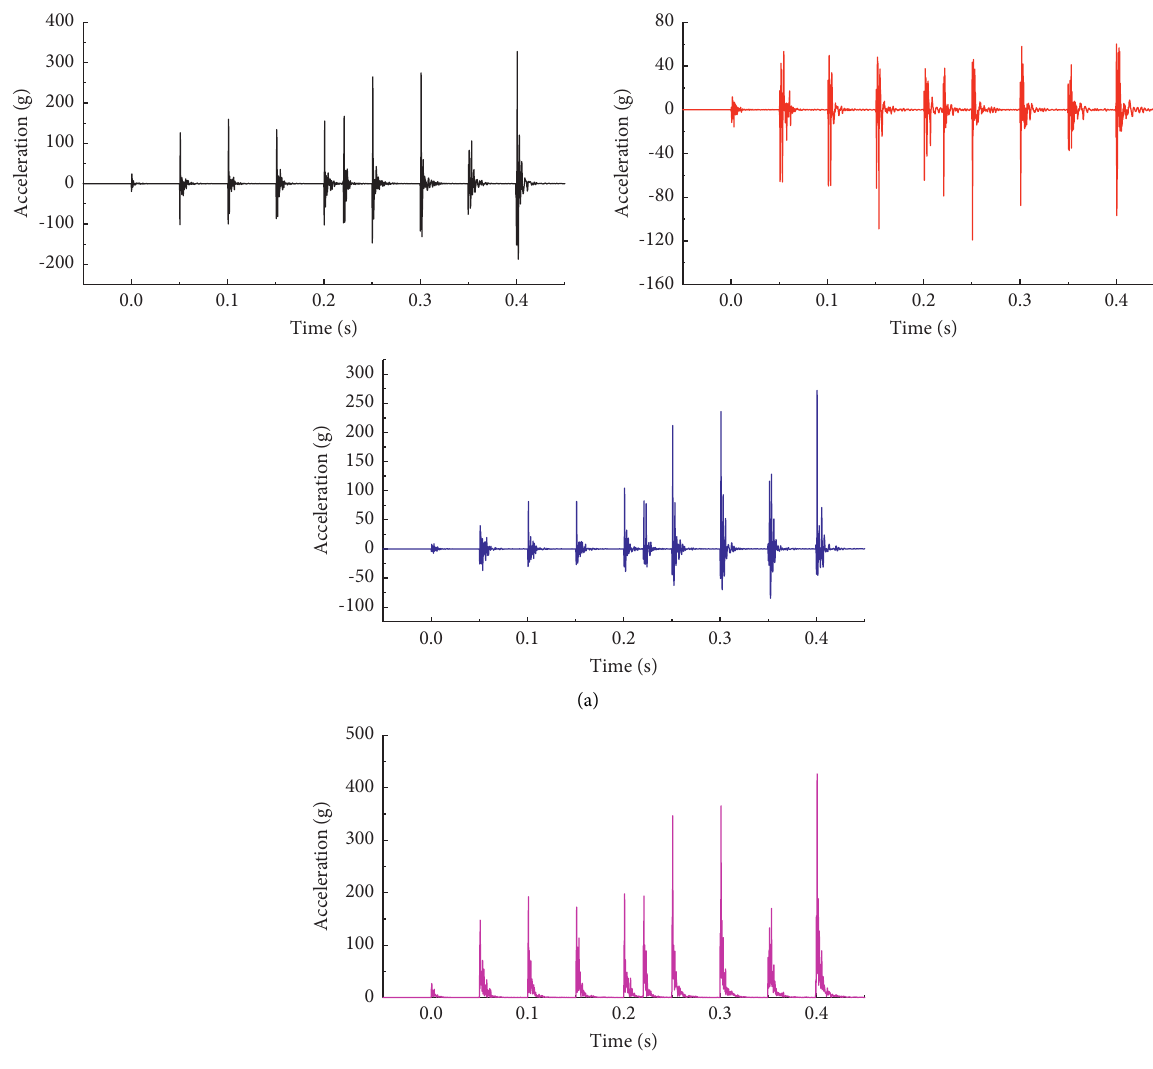
Figure 9: Acceleration waveform at 3m near tunnel face. (a) Three-direction waveform of blasting vibration acceleration. (b) Total acceleration